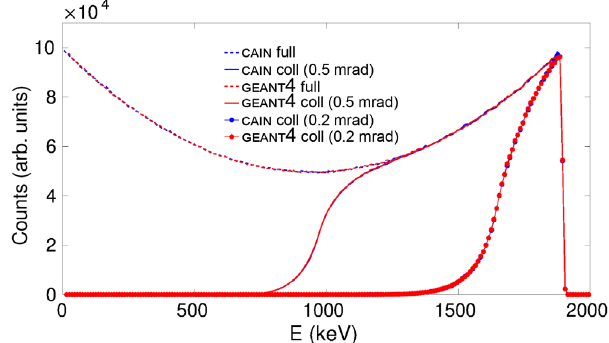
FIG. 3. Full and collimated spectrum of the NewSUBARU photon beam simulated with CAIN and GEANT 4 .